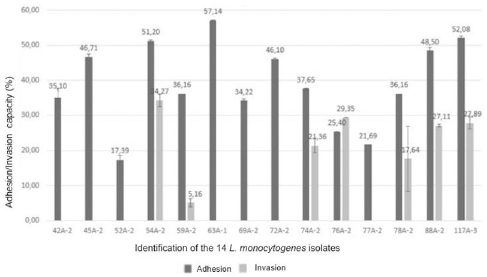
Fig 3. Results of invasion and cell adhesion tests using Caco-2 cells for 14 Listeria monocytogenes isolates. The values shown represent the average of the results, and the bars represent the standard deviation.